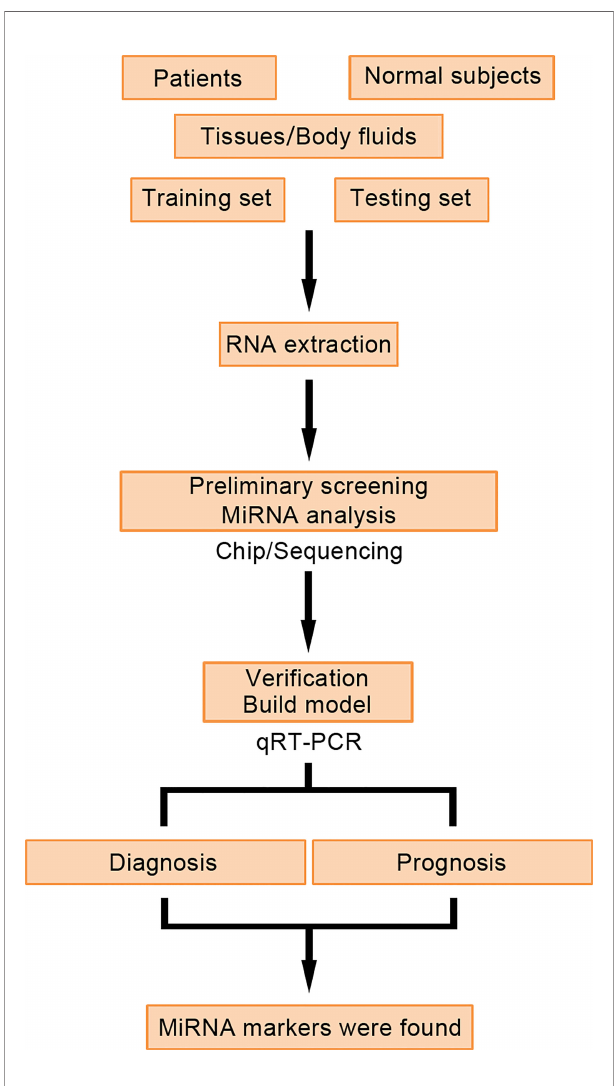
FIGURE 3 | Detection process and application of